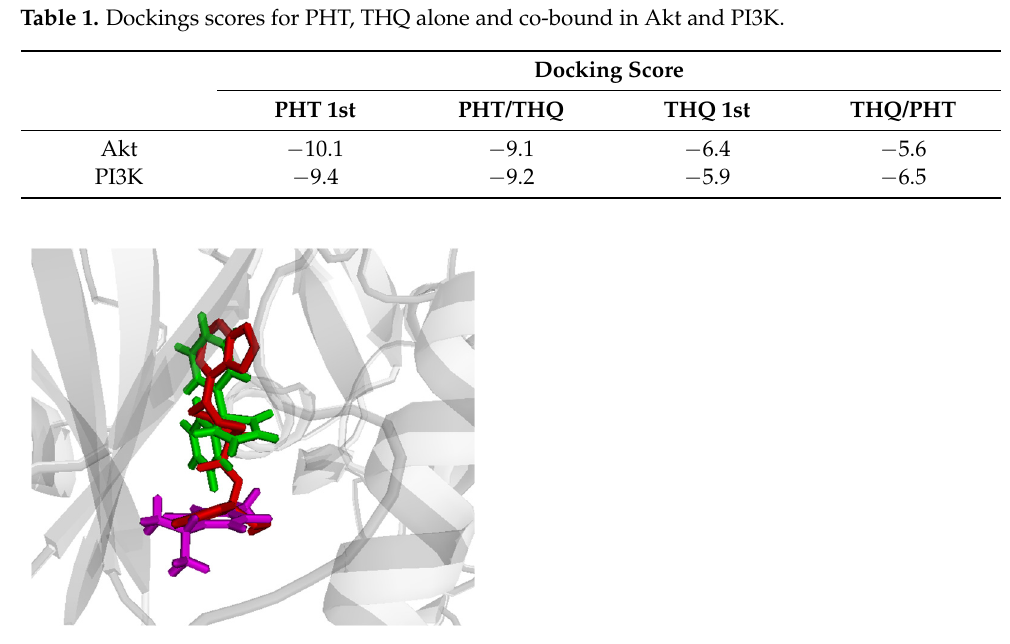
Figure 9. Comparative binding positions of co-bound PHT (green) and THQ (magenta) with the reference crystallized ligand (red) bound to the Akt active site. PHT and THQ indicate phenytoin and thymoquinone.